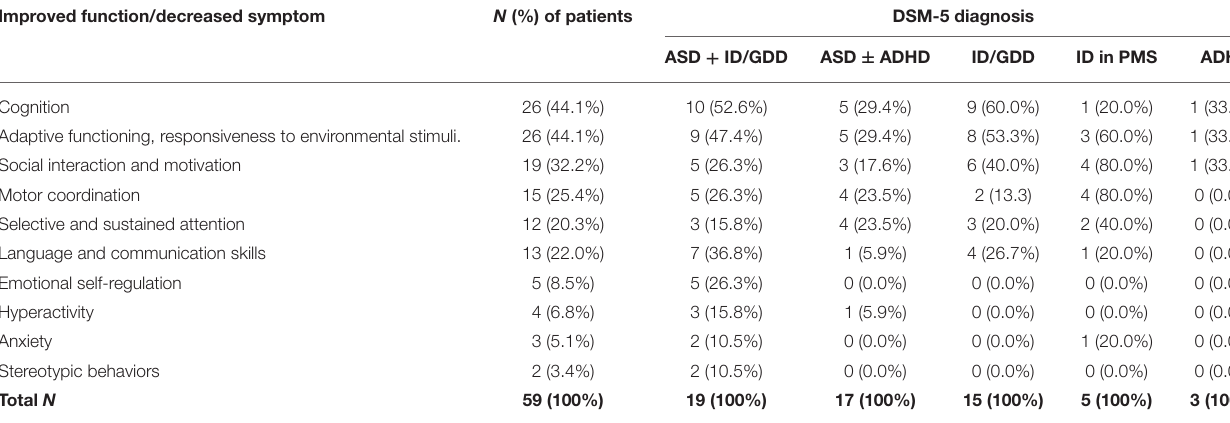
TABLE 3 | Therapeutic effects recorded following metabolic support therapy in the entire sample and by DSM-5